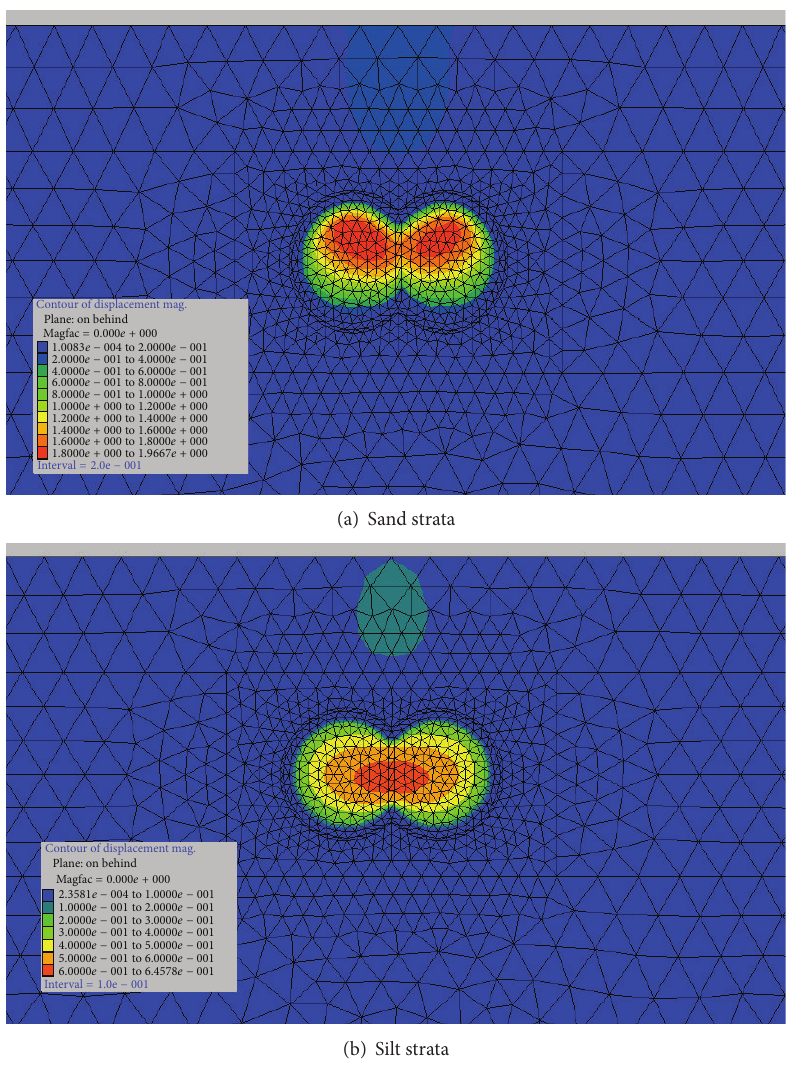
Figure 7: Cross-sectional failure form of the tunnel face.